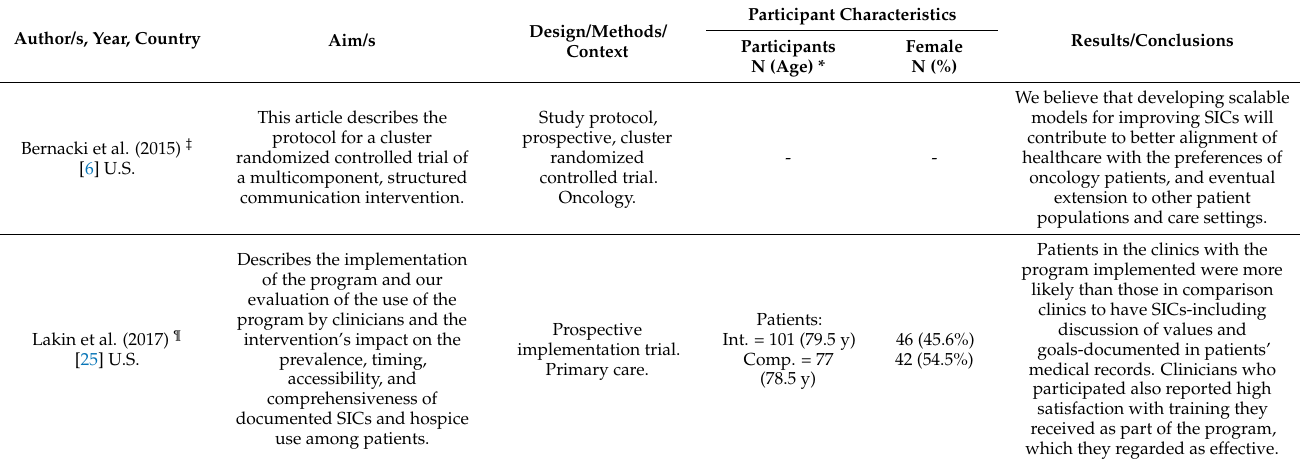
Table A2. Characteristics of the included literature †